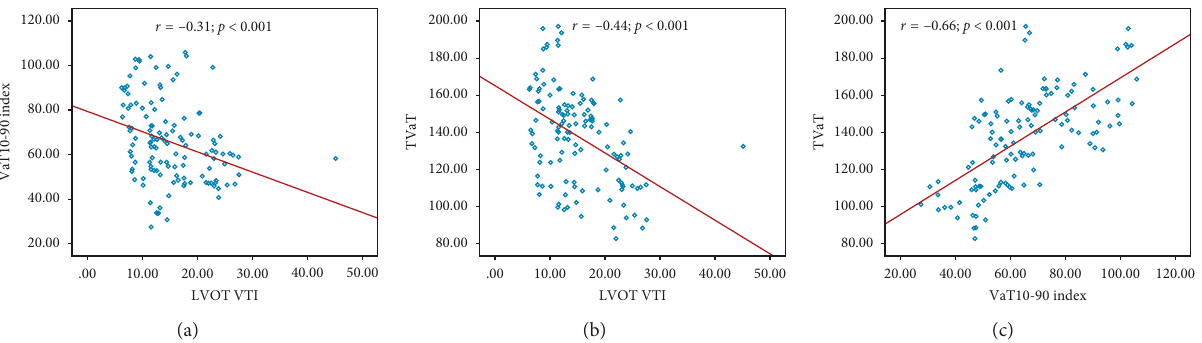
Figure 6: Correlations among LVOT VTI, TVaT, and VaT 10-90. LVOT VTI, left ventricular outflow tract velocity time integral; TVaT, total ventricular activation time; VaT 10-90 , ventricular activation time 10-90 . Pearson correlation; p < 0 . 001 for LVOT VTI/TVaTand LVOT VTI/ VaT 10-90